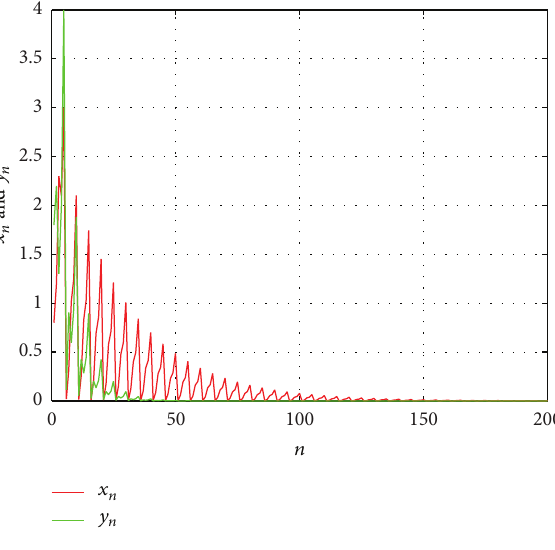
Figure 1: The plot of system